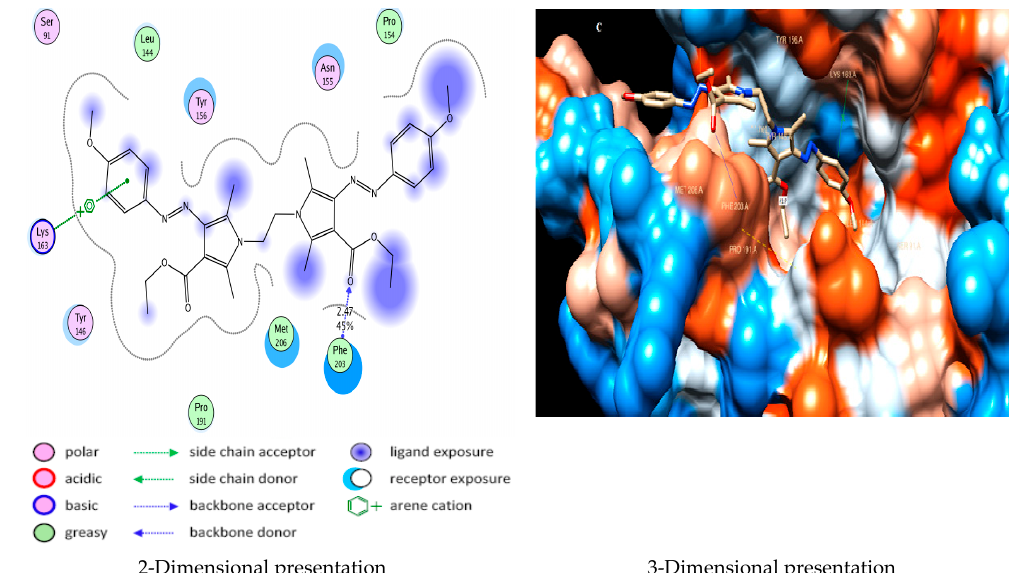
Figure 3. Docking of compound 5c into E. coli Enoyl reductase Enzyme (PDB ID: 1LXC) showing arene-cation interaction with Lys163 and hydrogen bond with Phe 203.